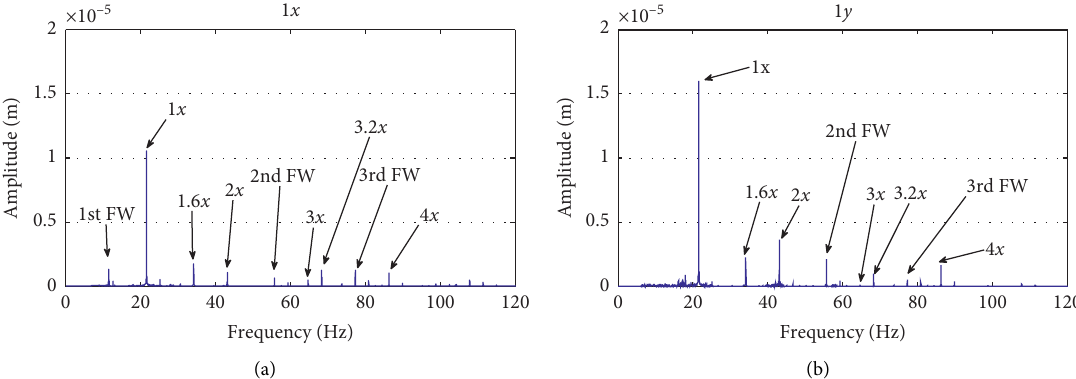
Figure 23: Spectrum of misalignment and unbalance at bearing 1, Ω